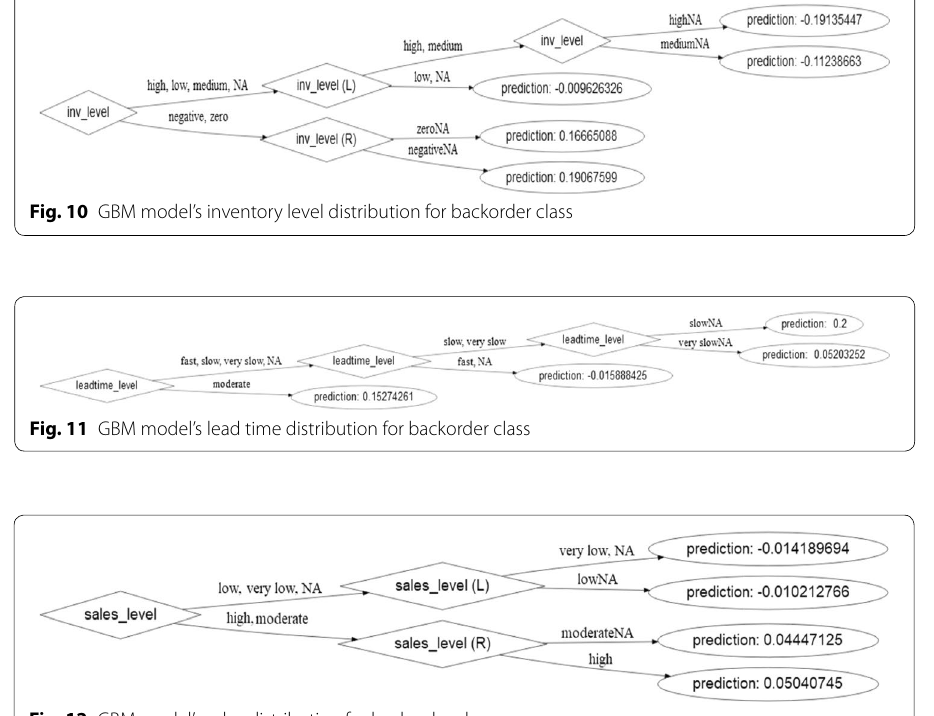
Fig. 12 GBM model’s sales distribution for backorder